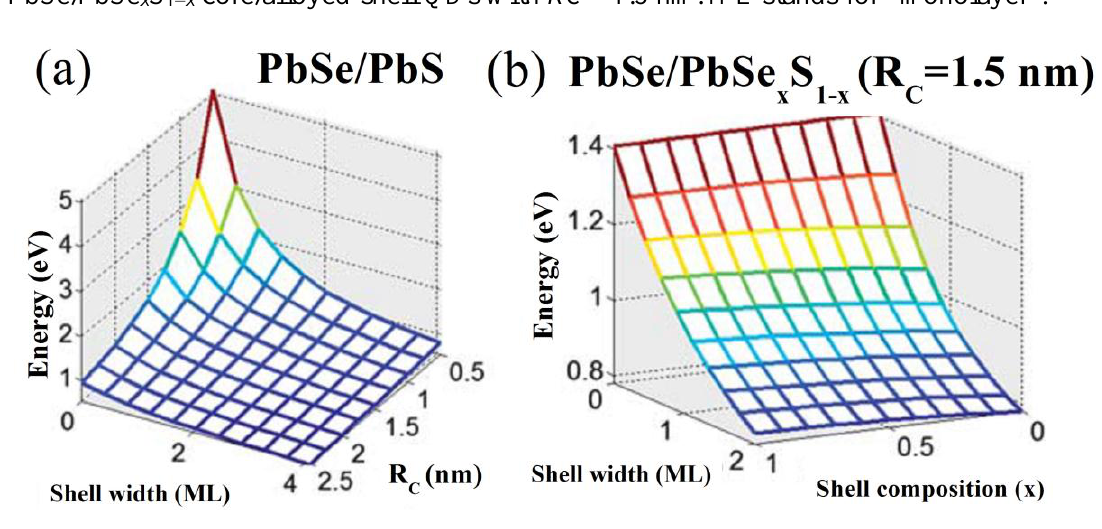
Figure 4. Variation of the ground-state exciton energy, Eg , with ( a ) core radius, R c, and shell thickness, W , in PbSe/PbS QDs, and ( b ) shell thickness, W , and composition, x ,